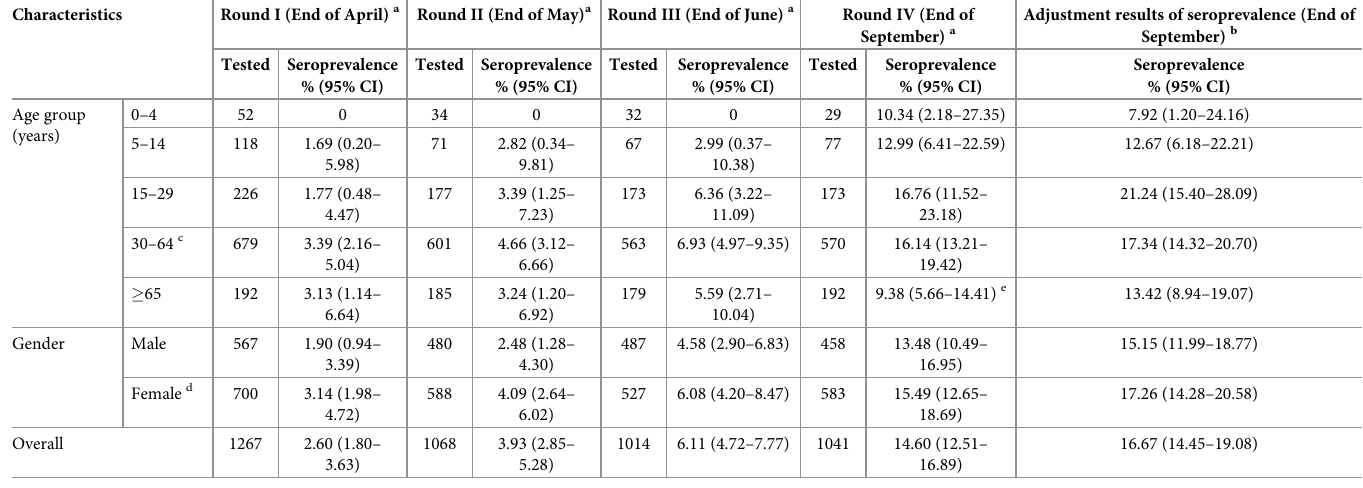
Table 1. Overview of four consecutive seroprevalence surveys by age and gender between April and September, 2020 in Vojvodina, Serbia.